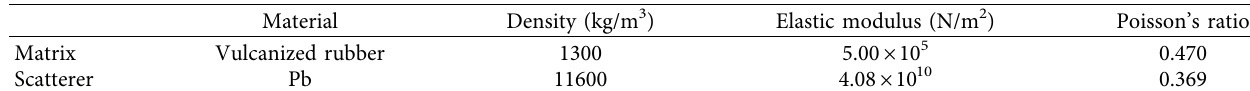
Figure 1: Damped rail with two-dimensional honeycomb PCs. (a) Schematic illustration. (b) Unit cells. (c) The first Brillouin zone. Table 1: Material parameters of matrix and scatterer.